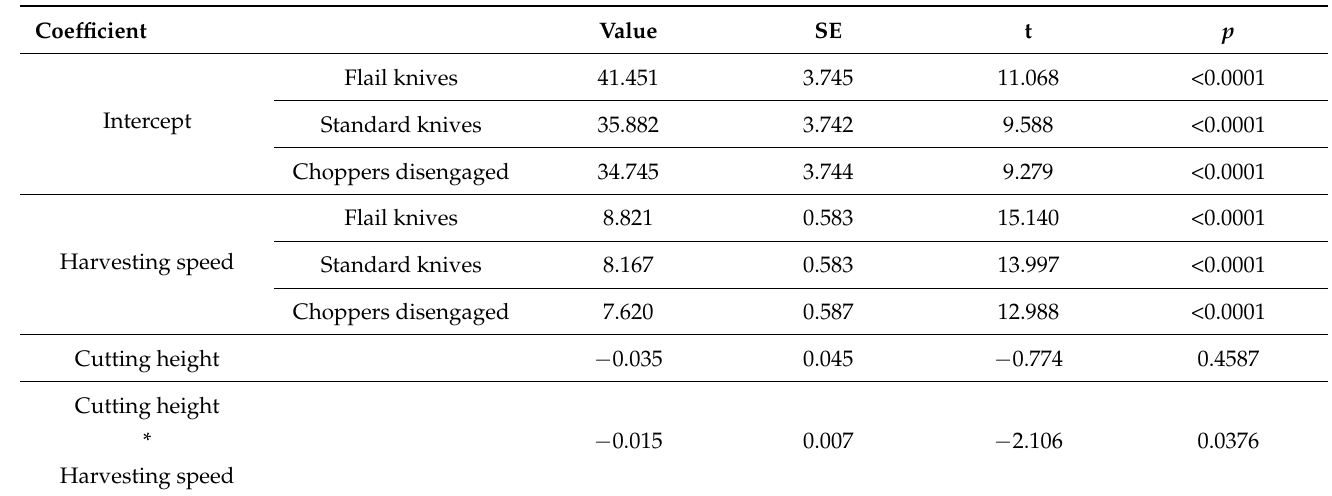
Table A3. Coefficients of the linear mixed effects regression model for the dependent variable hourly fuel consumption of the combine harvester with corresponding standard errors (SE), t-values (t) and p -values ( p